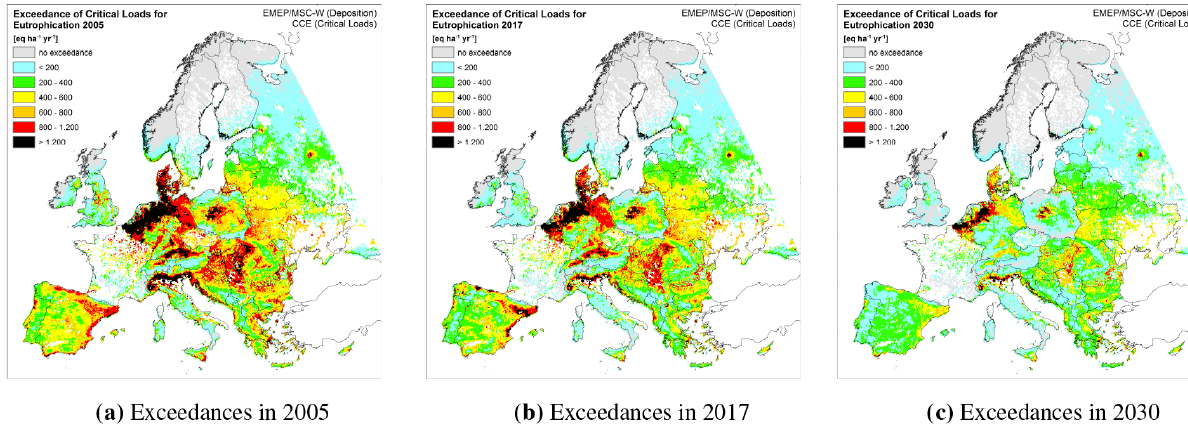
Figure 6. Fraction of NH 3 in reduced nitrogen (NH 3 + NH